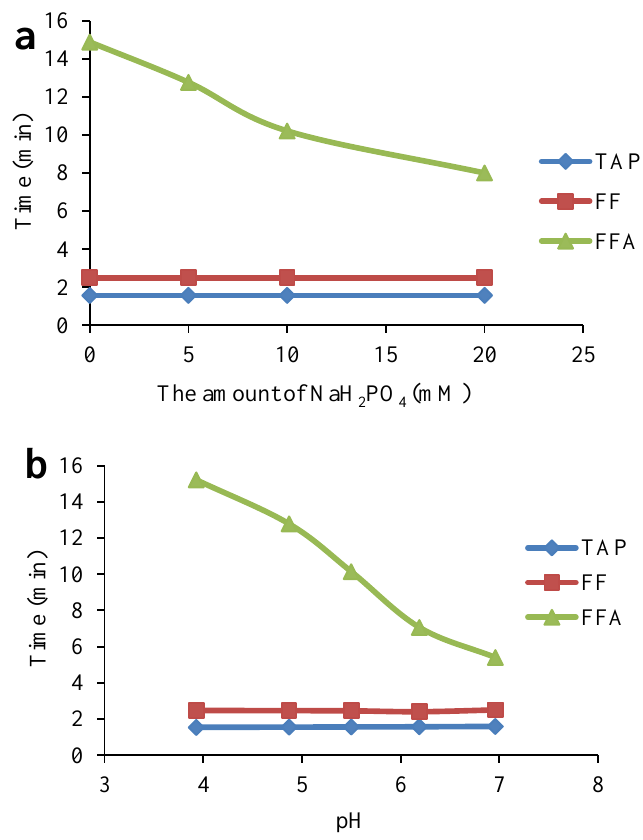
Figure 1. E ff ects of the amount of NaH 2 PO 4 ( a ) and the mobile phase pH ( b ) on the retention times of the targets.